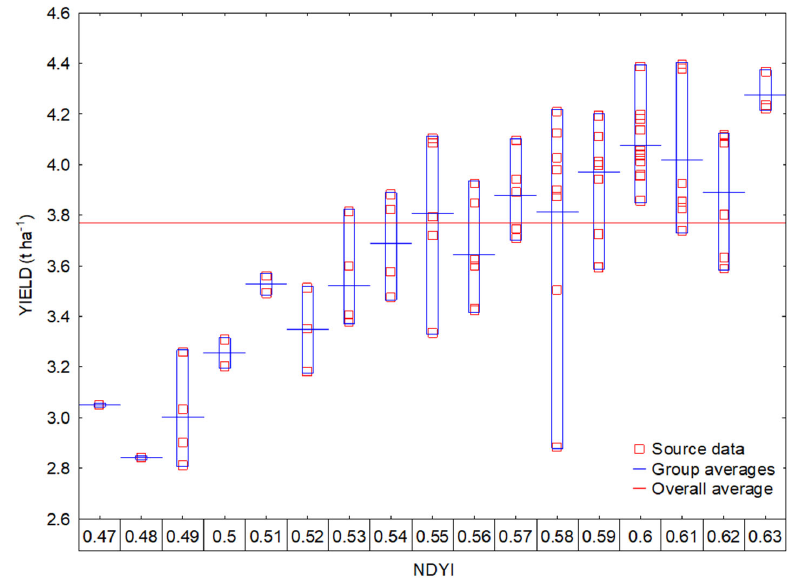
Figure 9. Graph of the variance of YIELD variable in relation to the measured BNDVI values (N = 80). Source data (red squares) show the yields of each plot ( Y − axis) divided into 9 groups according to BNDVI measured on each plot, ranging from 0.81 to 0.89 (9 values; X − axis). The parcels in each of the 9 groups have the same BNDVI value.